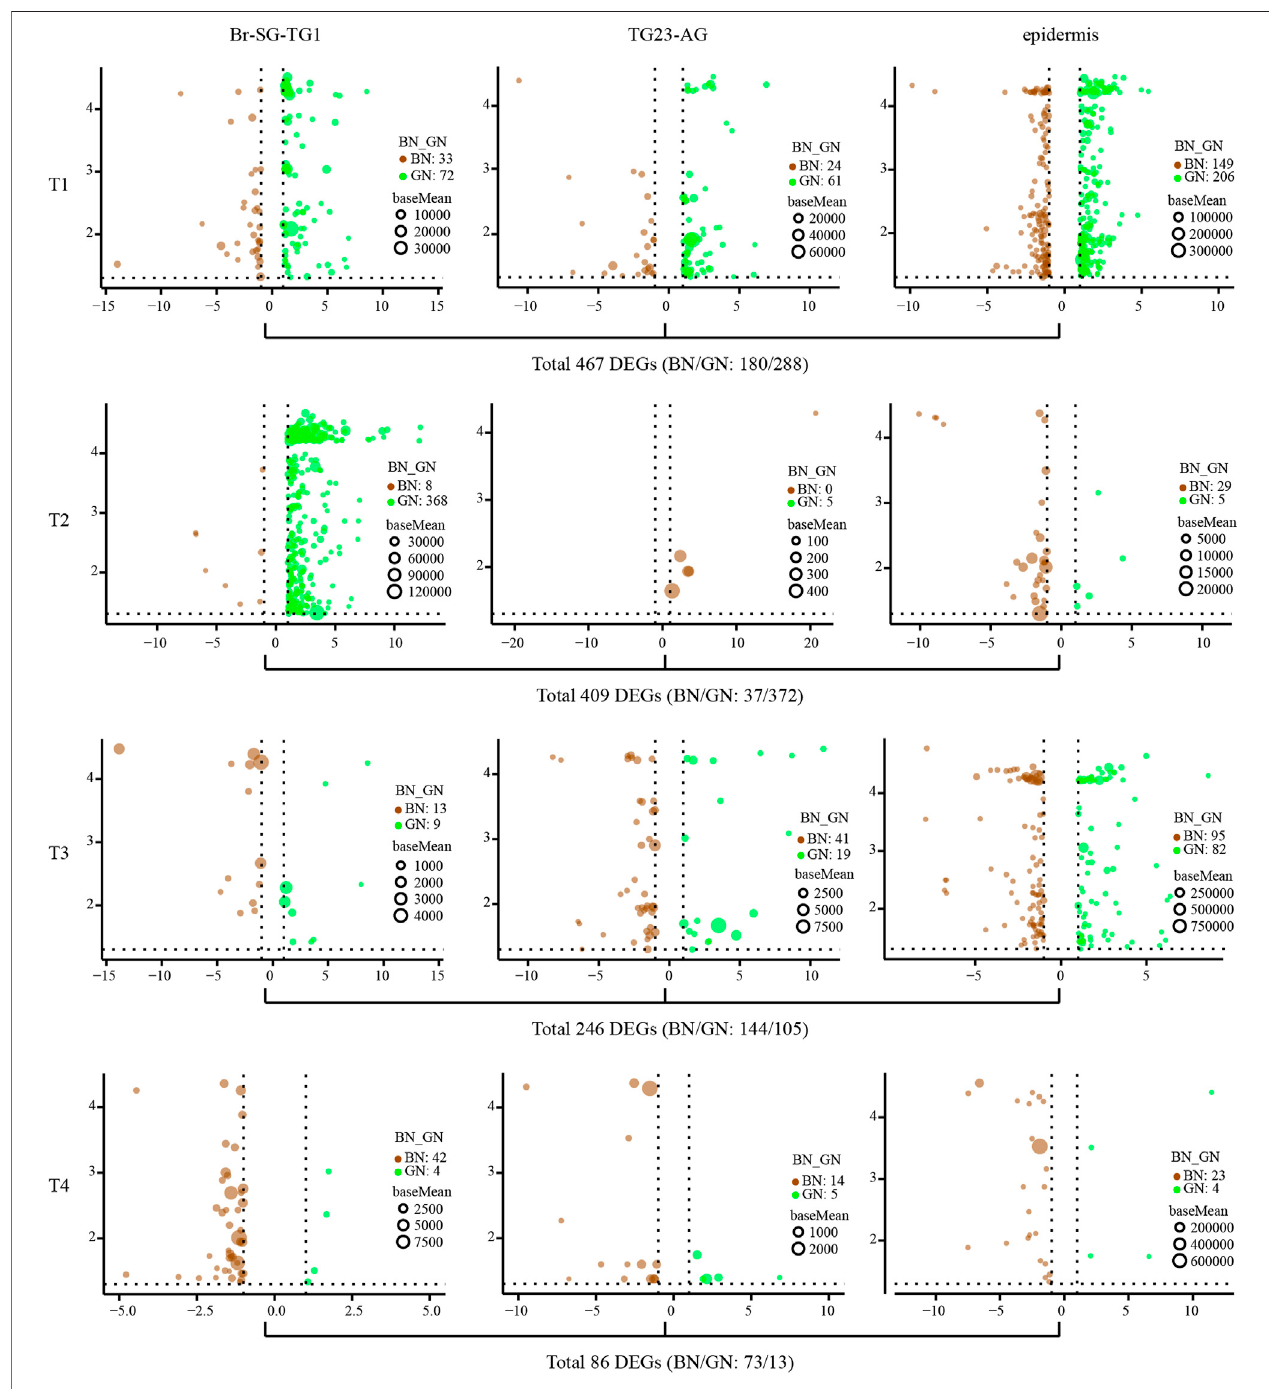
FIGURE2| The analysisofdifferential expression genes(DEGs) ofthree kindoftissues(Br-SG-TG1, TG23-AG,and epidermis)undergreenand brown conditions atfourinvestigatedtime-points(T1,T2,T3,andT4)inpupalcolorformationof Papilioxuthus .Thex-axisandy-axisarelog2foldchangeandnegativelog10transformed adjusted P -value (padj), respectively. Full information of tissues and periods refers to Figure 1 .